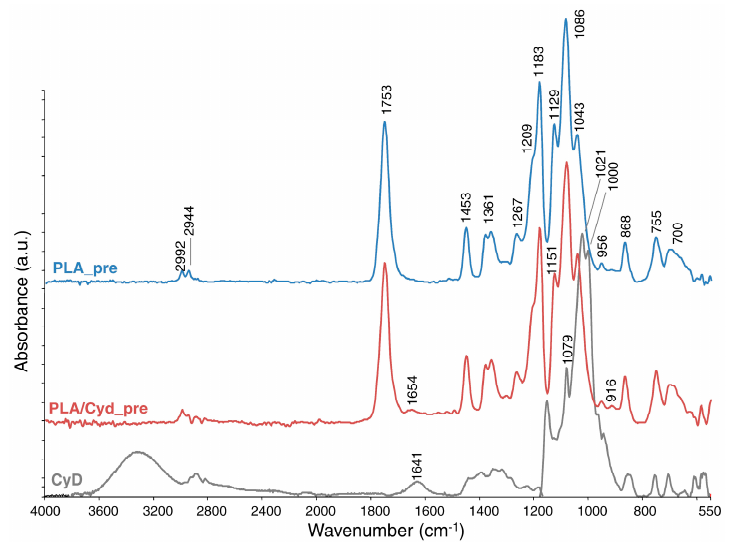
Figure 5. Typical spectra of the filter containing PLA and CyDs.